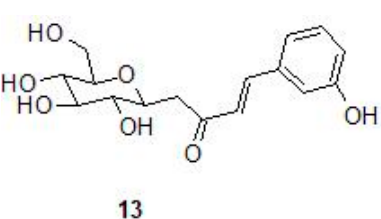
Figure 7. Chemical structure of C -cinnamoyl glycoside ( 13 ).